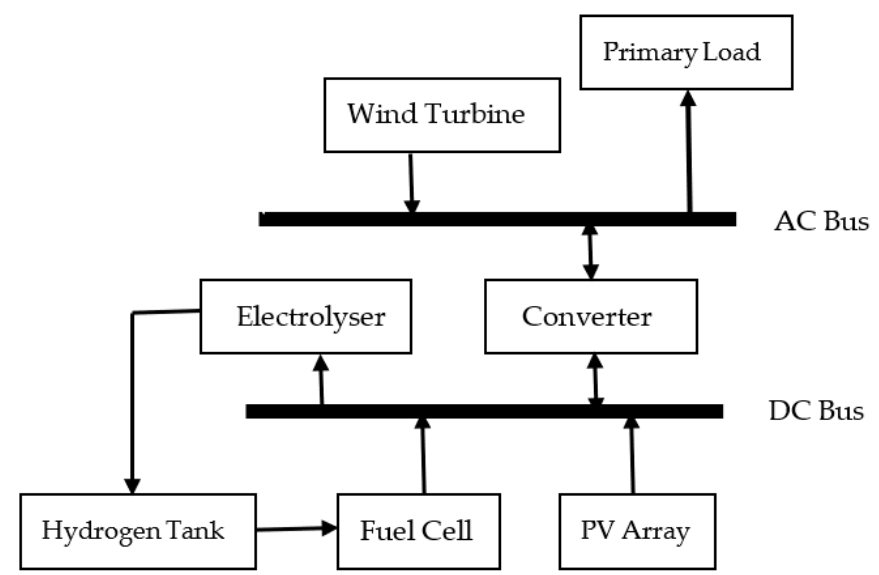
Figure 4. Schematic diagram of the proposed system (PV-Wind-Fuel Cell). Table 2. Technical data and study assumptions of PV, diesel unit, inverter, and batteries [37–39].